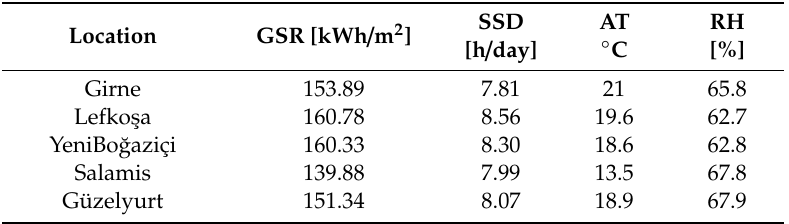
Table 5. Summary for all chosen locations in Northern Cyprus.